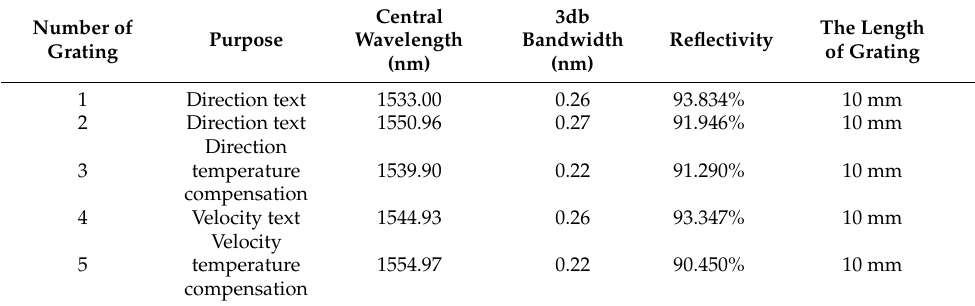
Table 1. The parameters of the